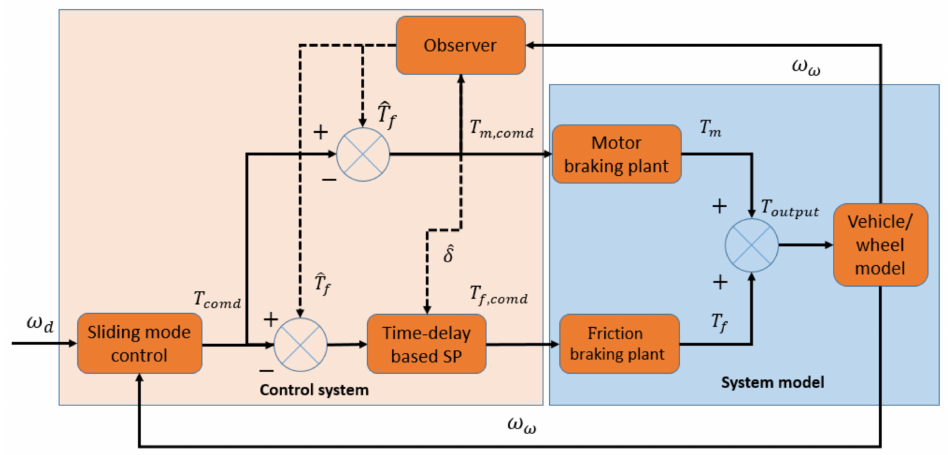
Figure 4. Whole control system